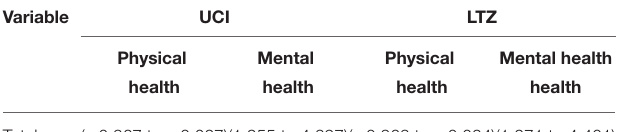
TABLE 7 | Conley et al. (63) plausibly exogenous